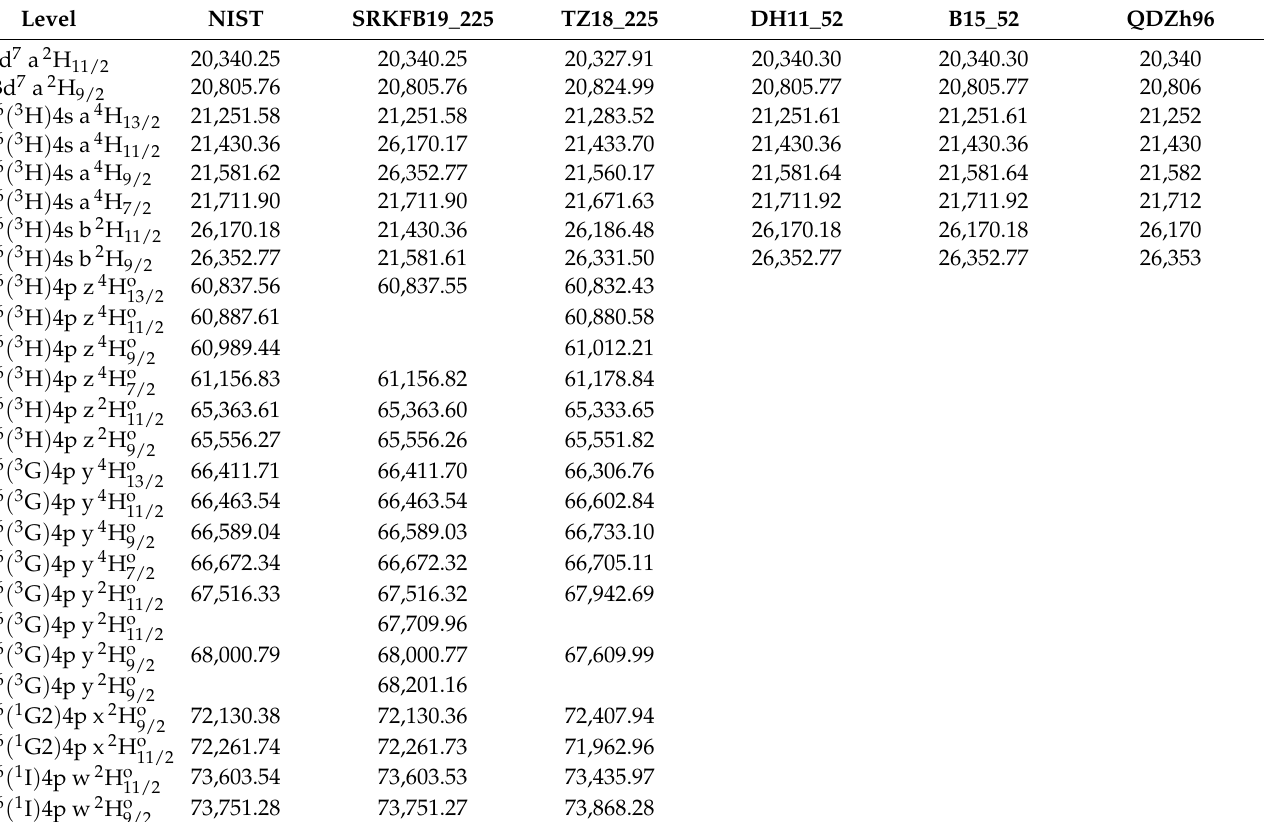
Table 6. Comparison of NIST energies (cm − 1 ) for levels in Fe II displaying a total orbital angular momentum quantum number L = 5 with those listed in different atom datasets (see Section 4.2). Questionable level assignments are found in atom_SRKFB19_225.